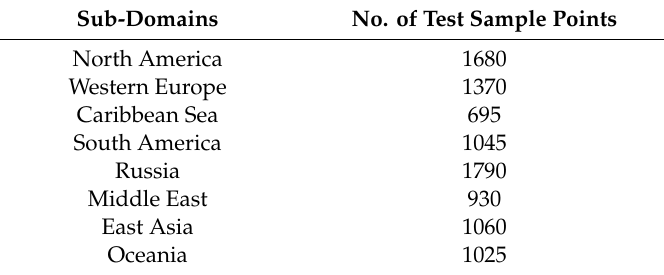
Table 2. Numerical setup for the